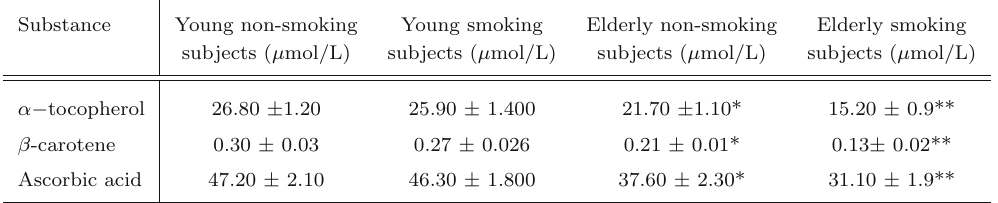
Table 1 Plasma concentrations of alpha-tocopherol, beta-carotene, and ascorbic acid.